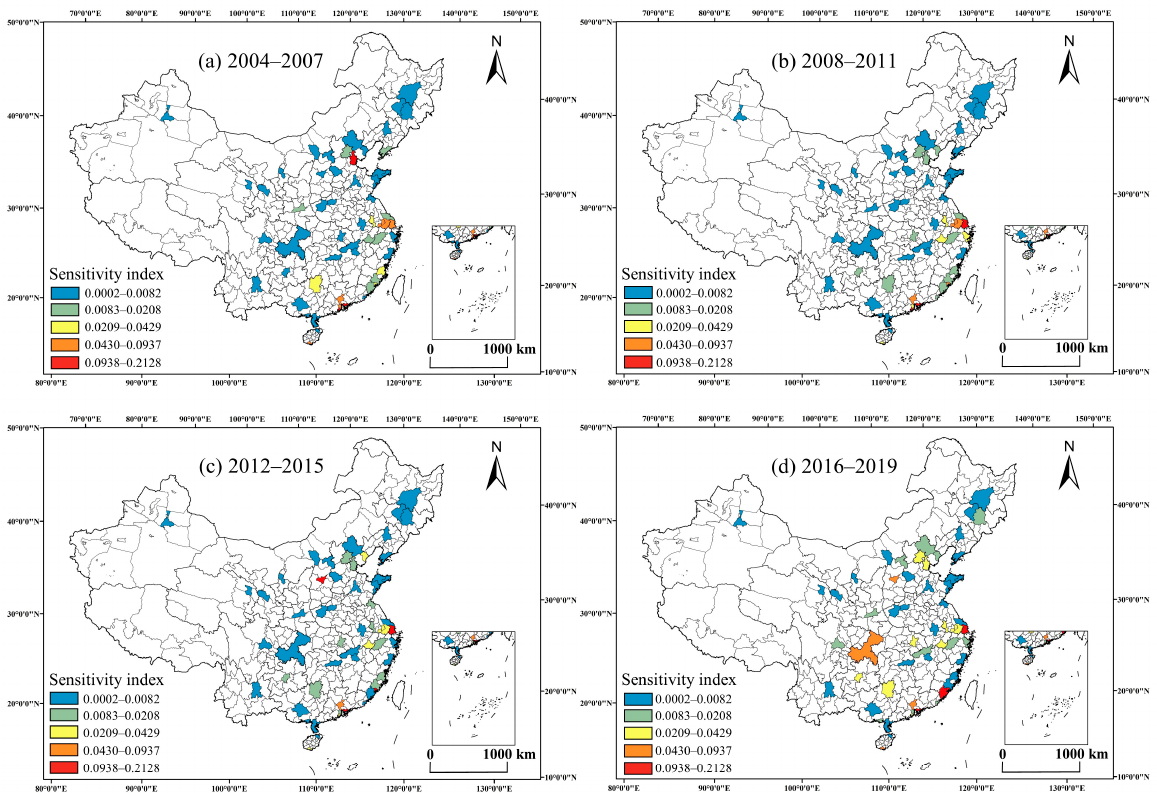
Figure 5. Spatiotemporal evolution of the sensitivity index (( a ) Average sensitivity index for 2004–2007 were shown; ( b ) Average sensitivity index for 2008–2011 were shown; ( c ) Average sensitivity index for 2012–2015 were shown; ( d ) Average sensitivity index for 2016–2019 were shown).